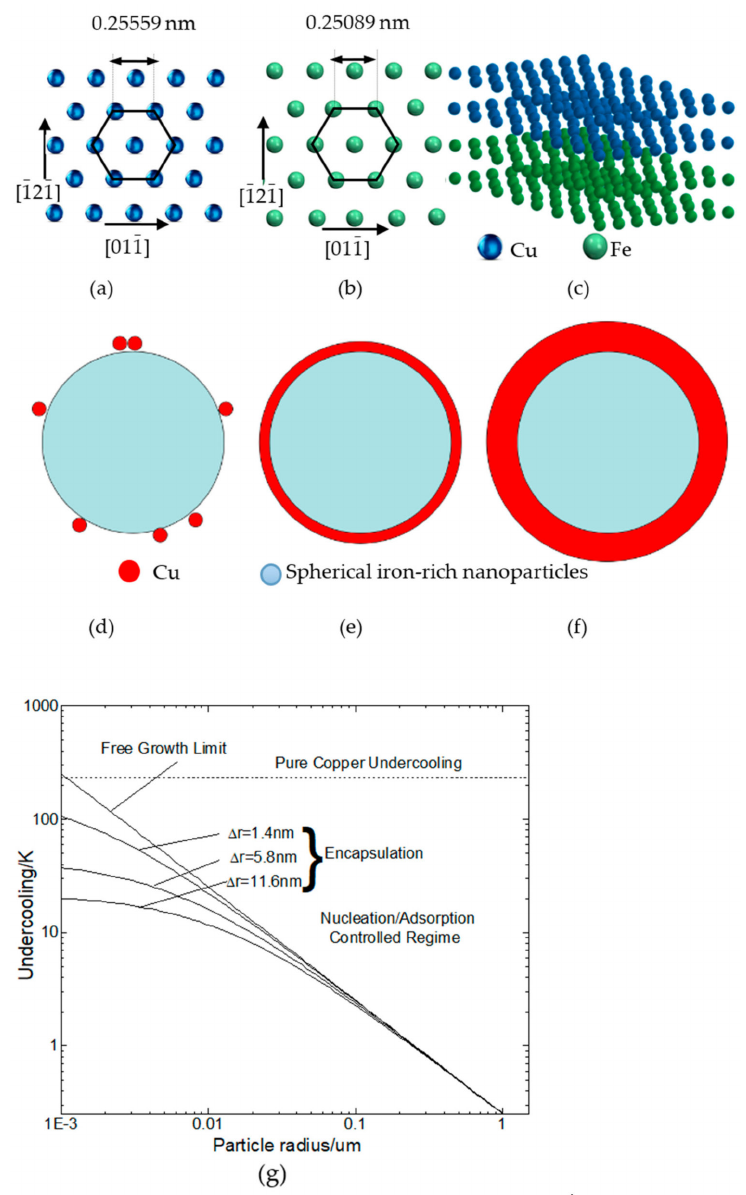
Figure 15. Schematic illustration of the mechanism for adsorption of Cu on (111) surface of an iron-rich nanoparticle: Arrangements of atoms in ( a ) (111) plane of Cu; ( b ) Terminated (111) plane of the nanoparticle surface; ( c ) Atomic matching at the Cu/Fe interface; ( d – f ) The formation process of encapsulated nanoparticle; ( g ) The minimum undercooling required for effective nucleation proposed by Greer